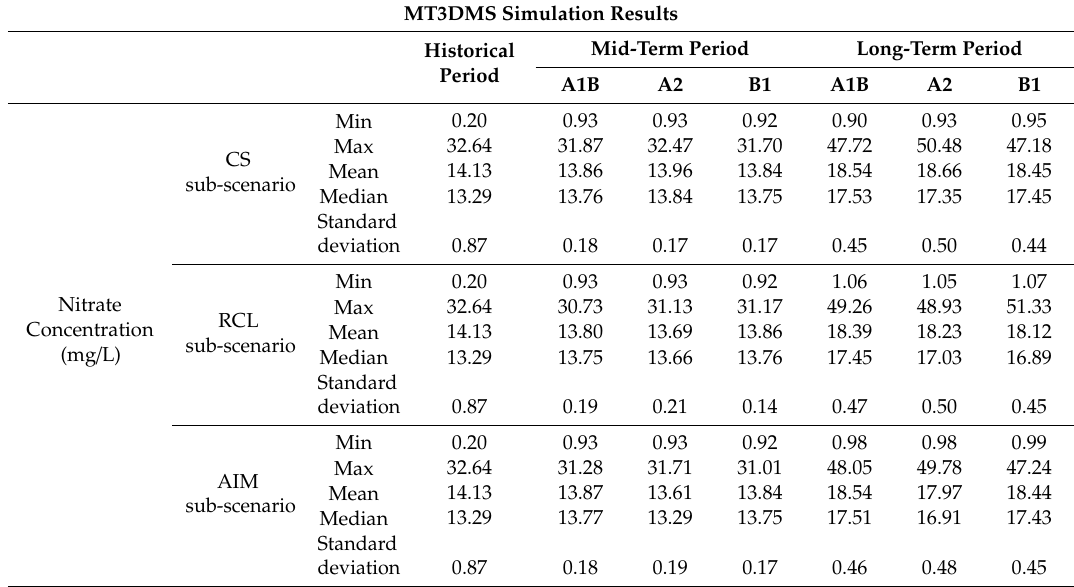
Simulation results from MT3DMS for water demand sub-scenarios of no reservoir operation strategy.